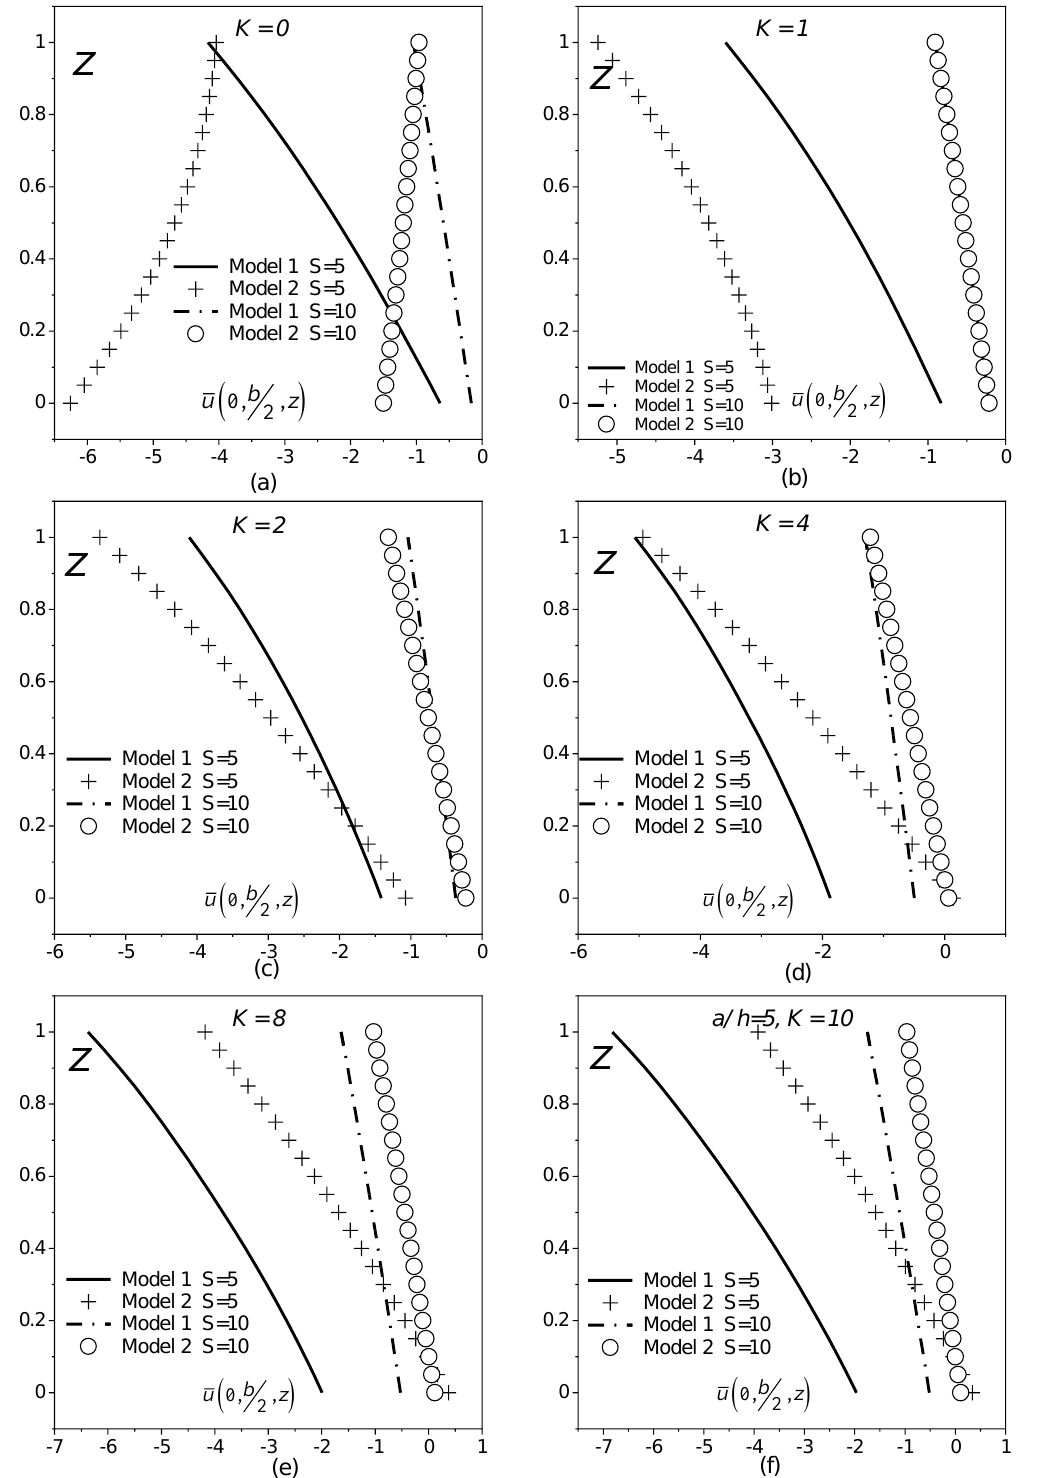
Fig. 6. Thickness variation of normalized in plane displacement ( u ) for different material graded FG square laminate for material set